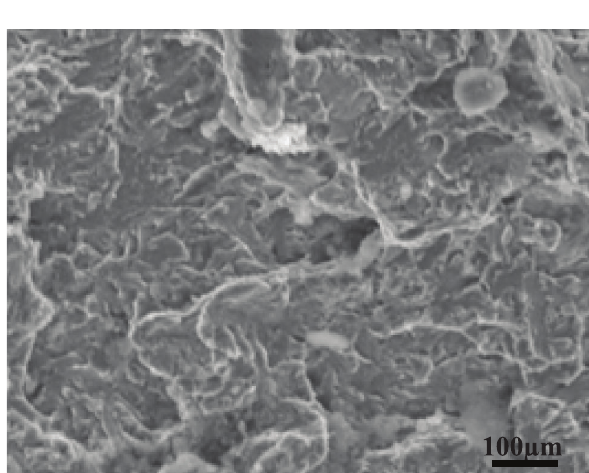
Fig. 6: Fractographic analysis of fracture surface showing the evidence of intergranular brittle